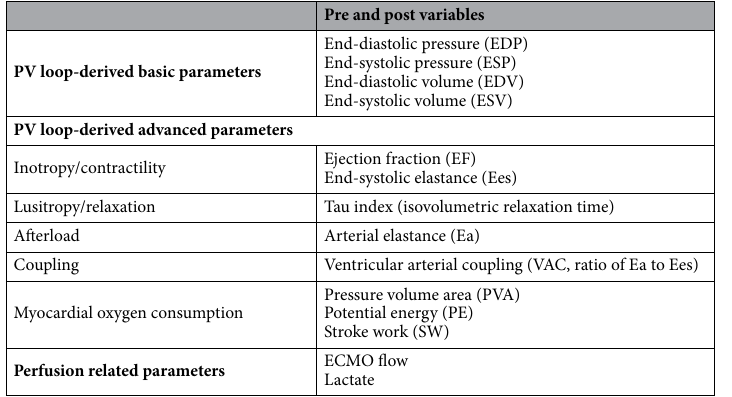
Table 1. Pressure–volume loop derived parameters and perfusion parameters.